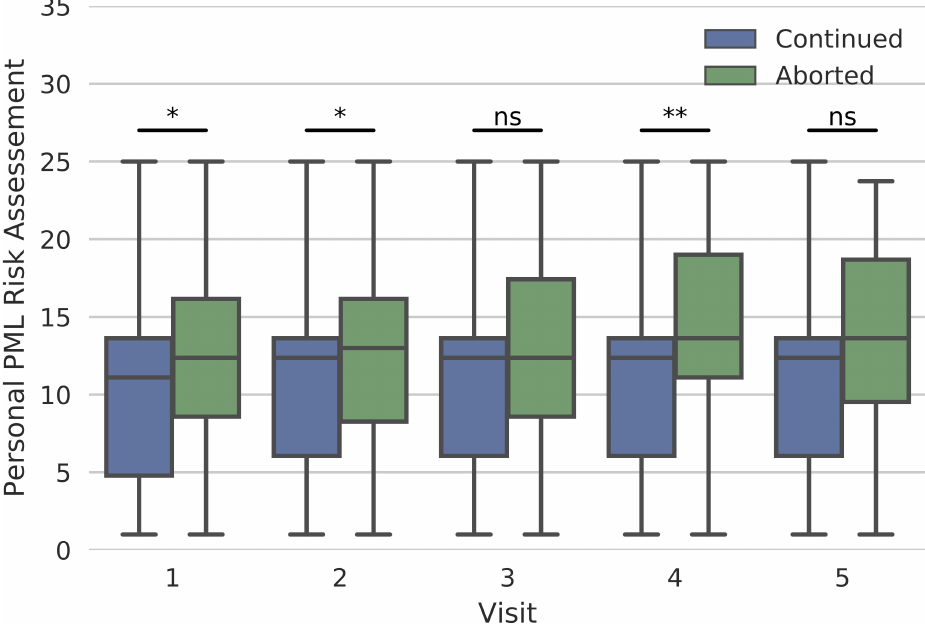
Fig 1. Assessment of personal PML risk at visit 1 to 5 for patients continuing and discontinuing natalizumab (NTZ). Patients discontinuing NTZ (green)assessed the personalPML risk higheron a visual analogscale from 0 to 25 points (0 = ‘low’, 25 = ‘high’)in all visits than patients continuingNTZ (blue) ( * p < 0.01; ** p < 0.0002; ns = not significant).